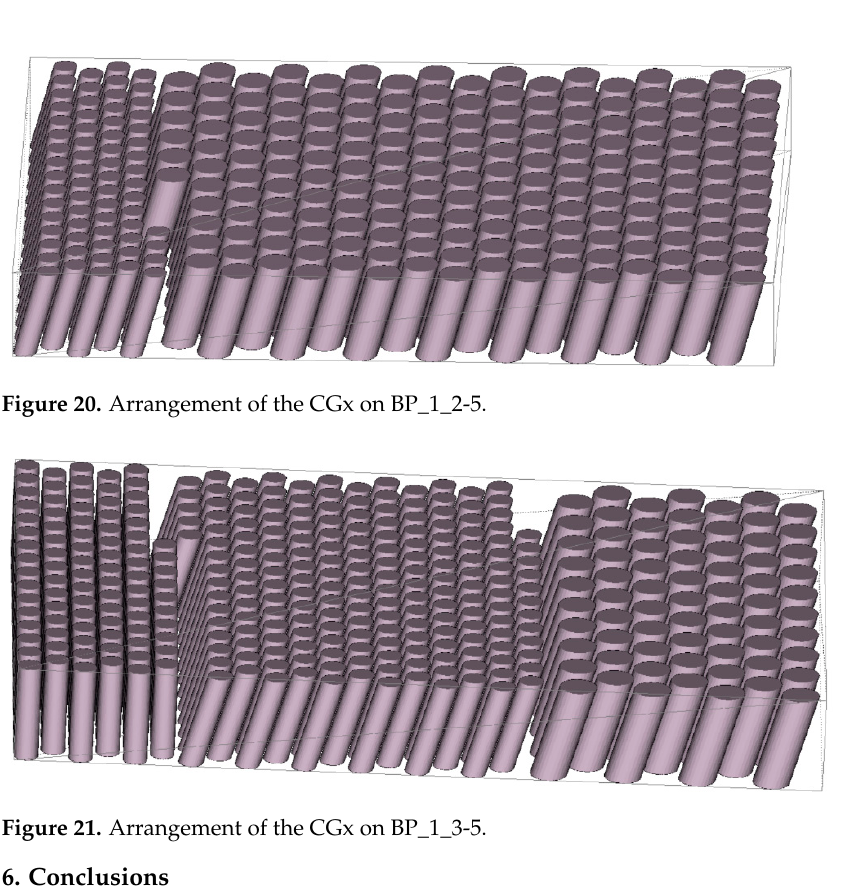
Figure 19. Arrangement of the CGx on BP_1_2-4 and 1_3-4.